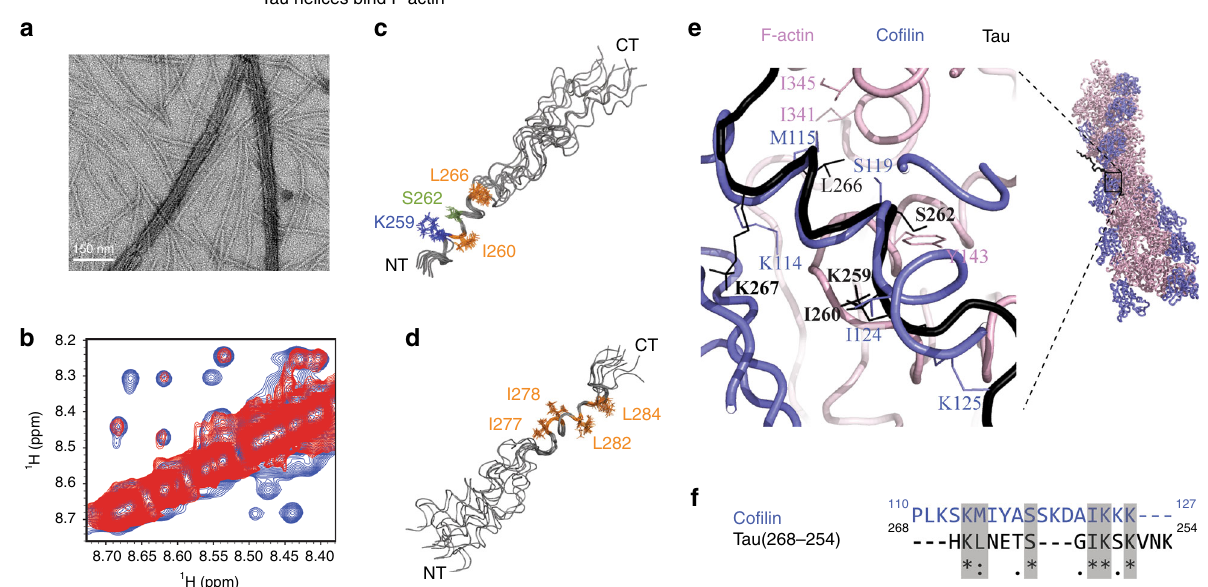
Fig. 3 Tau(254 – 290) adopts helical structure upon binding to fi lamentous actin. a Electron micrograph demonstrating bundling of F-actin in presence of Tau(254 – 290). b Amide – amide region from 2D NOE spectra of Tau(254 – 290) in the presence (blue) and absence (red) of F-actin. c Ten lowest-energy conformers of F-actin bound Tau(254 – 290). Structures were aligned from N255 to H268. Hydrophobic residues are colored orange. In addition, K259 (blue) and S262 (light green) are highlighted. d Ten lowest-energy conformers of F-actin bound Tau(254 – 290) aligned from residue Q276 to V287. e Crystal structure of co fi lin (blue) in complex with F-actin (pink; PDB id: 3J0S), superimposed onto the F-actin bound form of Tau(254 – 290) as derived from protein – protein docking (black). Side chains of selected residues are shown. f Sequence alignment of co fi lin with residues 268 – 254 of